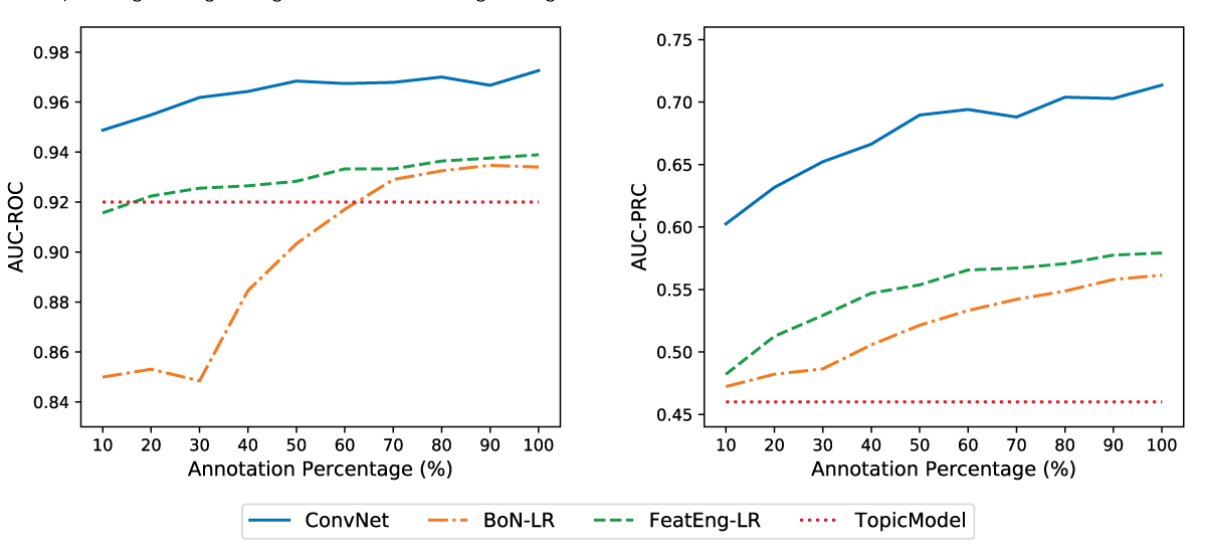
Figure 3. Area under the receiver operating characteristic and precision-recall curves obtained when training the supervised models using random subsamples of the manual annotations. TopicModel is reported as reference baseline. ConvNet obtained satisfactory results when trained using less manually annotated documents, showing robustness and scalability to the gold standard. AUC-PRC: area under the precision-recall curve; AUC-ROC: area under the receiver operating characteristic curve; BoN-LR: logistic regression with bag of n-grams; ConvNet: convolutional neural network-based architecture; FeatEng-LR: logistic regression with feature engineering.